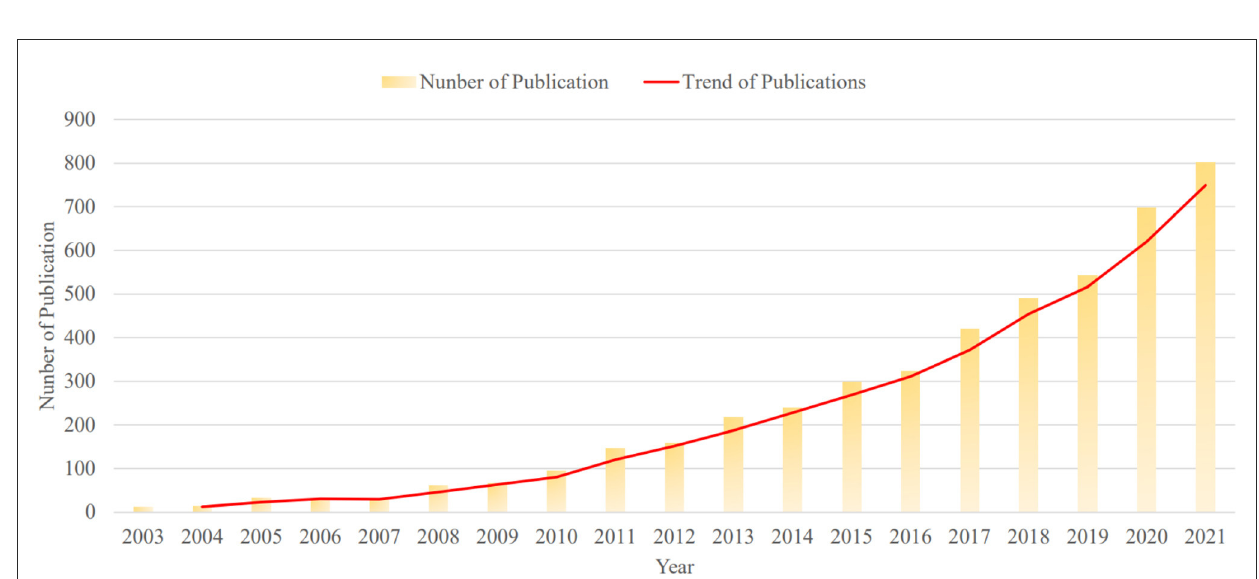
FIGURE2 The number and trend of publications on climate adaptation of the agricultural system